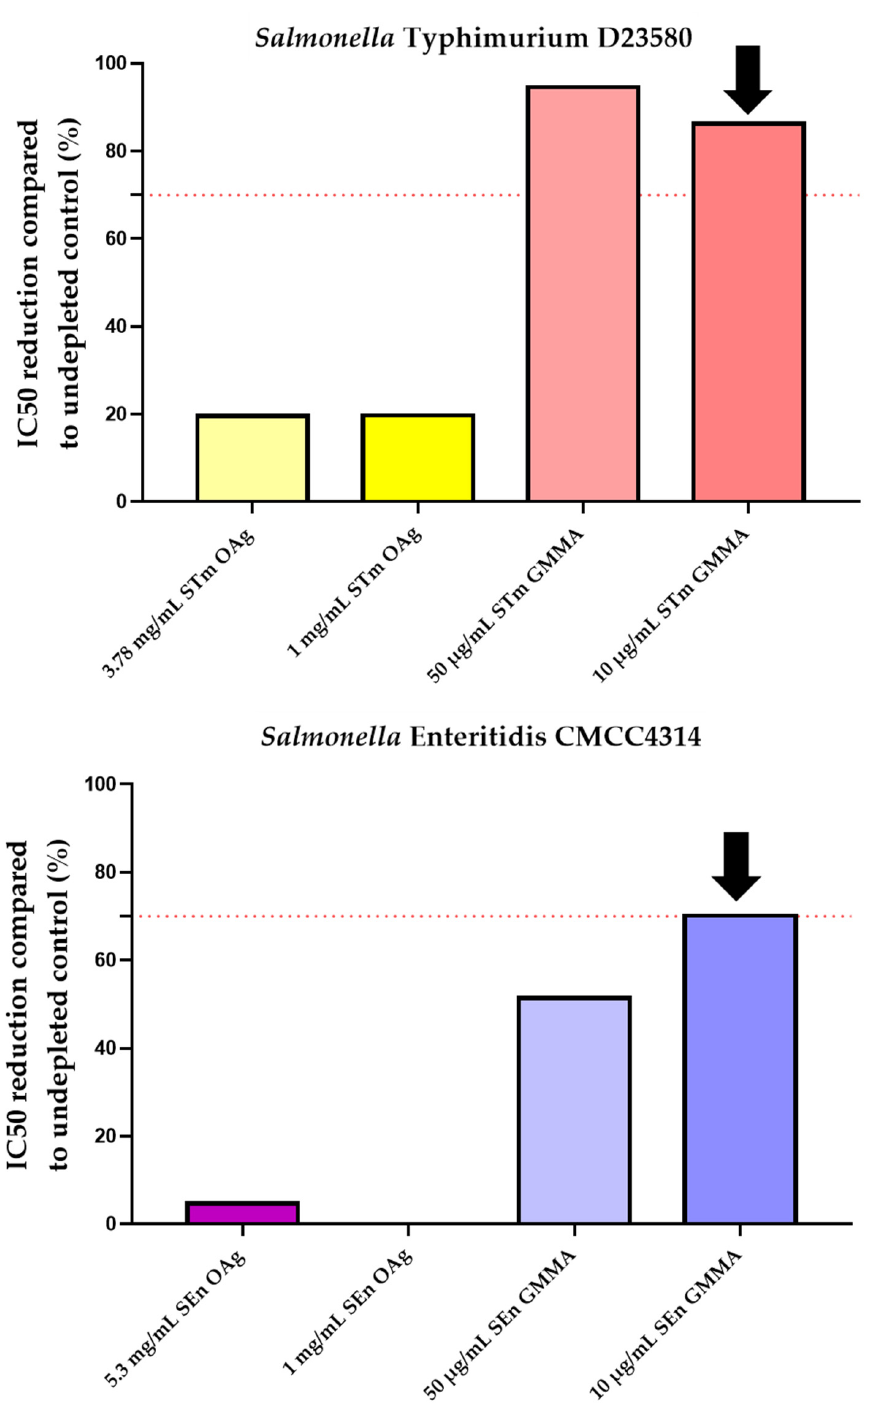
Figure 4. Homologous specificity for Salmonella strains: percentage of IC50 inhibition observed compared to control inhibited with equal amount of PBS. The lowest homologous S. Typhimurium and S. Enteritidis GMMA concentration that was able to inhibit ≥ 70% of the IC50 (indicated by the dotted red line) compared to the non-depleted control sample resulted to be 10 µg/mL, as indicated by the black arrows.